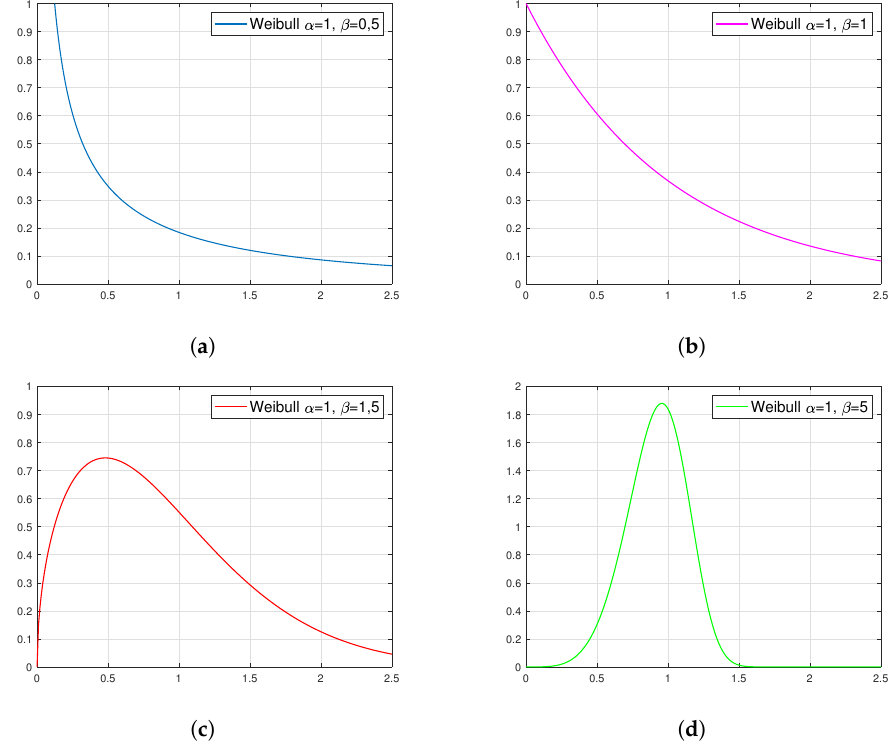
Figure 4. Examples of density plots for the Weibull distribution with specific parameters: ( a ) α = 1, β = 0,5, ( b ) α = 1, β = 1, ( c ) α = 1, β = 1,5 and ( d ) α = 1, β =